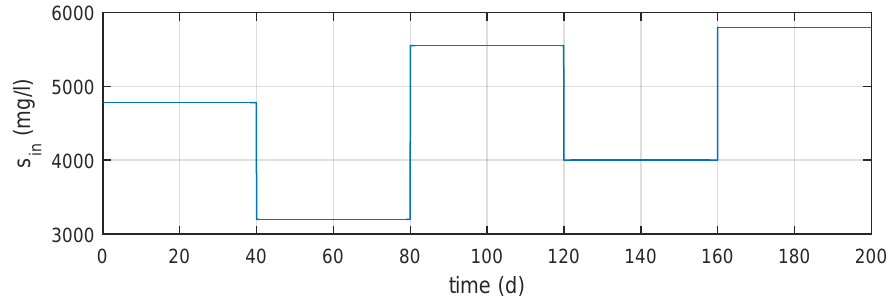
Figure 14. Inlet Acetate concentration ( s in ). The resulting HPR obtained by executing the optimization algorithm both in the FPGA and in Matlab is shown in Figure 15. The green dashed-line represents the HPR by the MEC model, the red line represents the maximum HPR computed in Matlab, while the blue dashed-line represents the maximum HPR computed by the